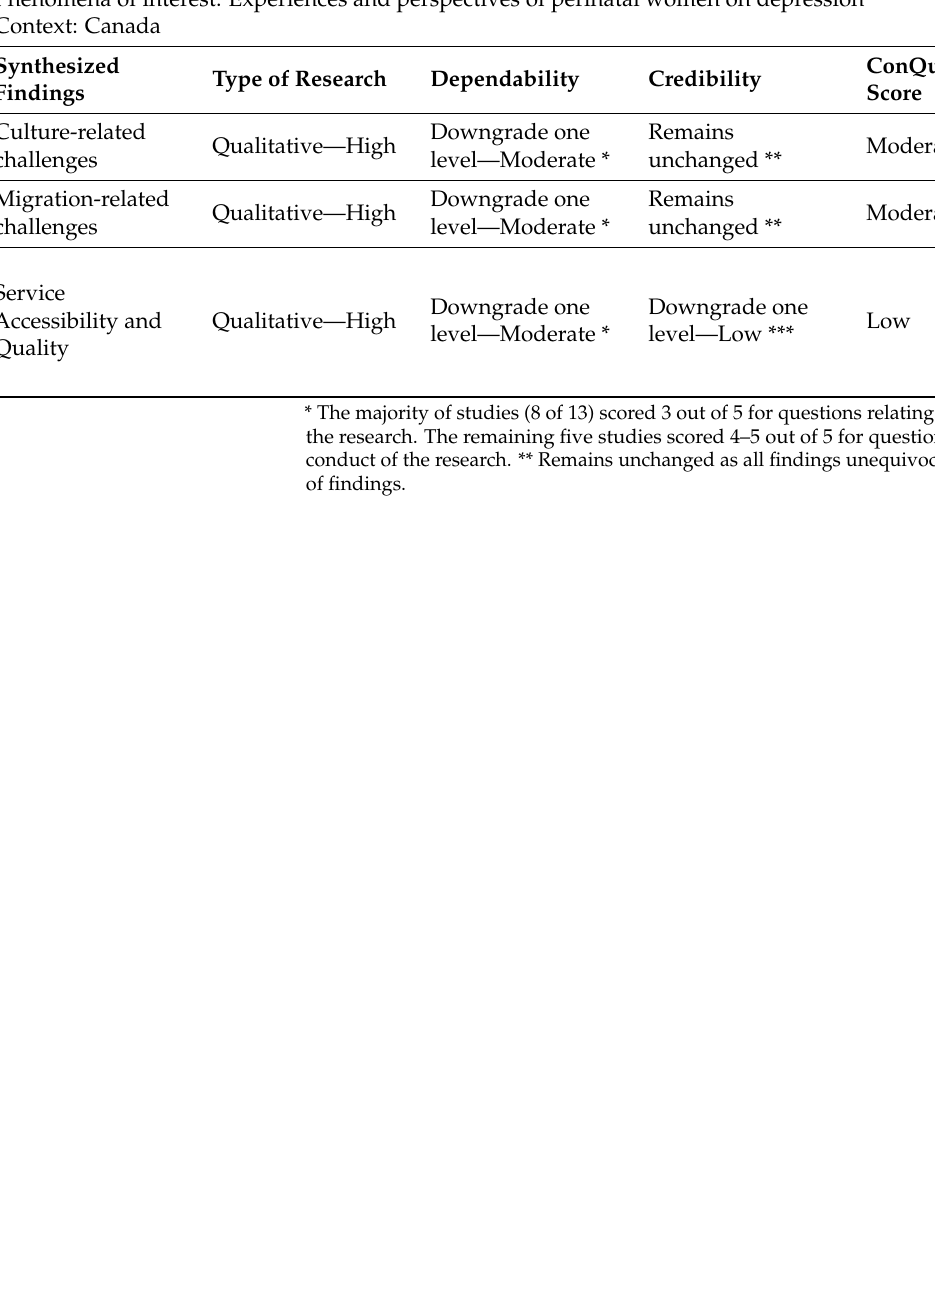
Table 1. ConQual Summary of